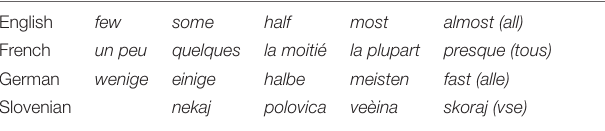
TABLE 1 | Experiment 1: Quantifiers per language used in target